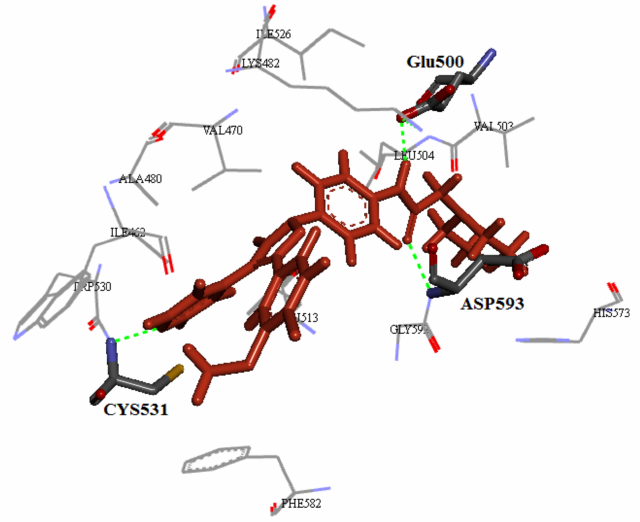
Figure 73. In silico binding interactions of compound 68 with V600E-B-RAF crystal structure